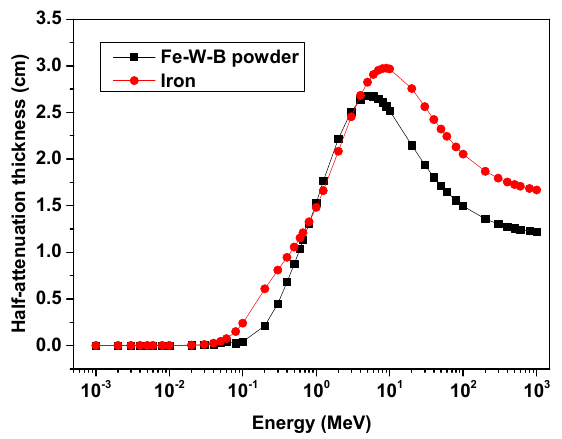
Figure 9. The comparison of half attenuation thickness of Fe-W-B amorphous powder and iron under different γ -ray energy conditions.